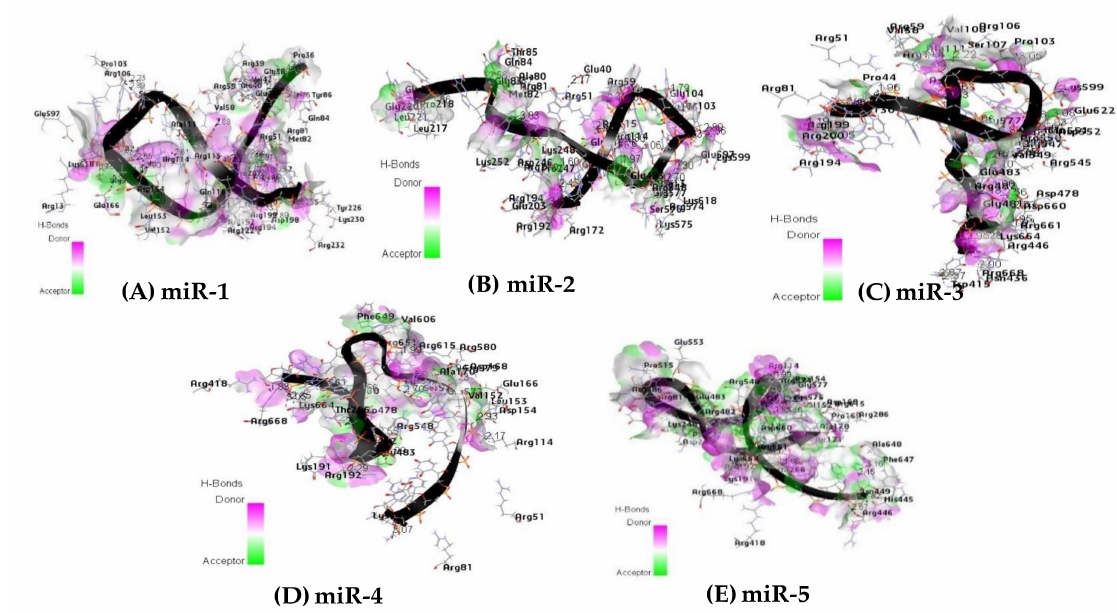
Figure 8. Hydrogen bond interaction between the residual amino acids of the receptor protein and the